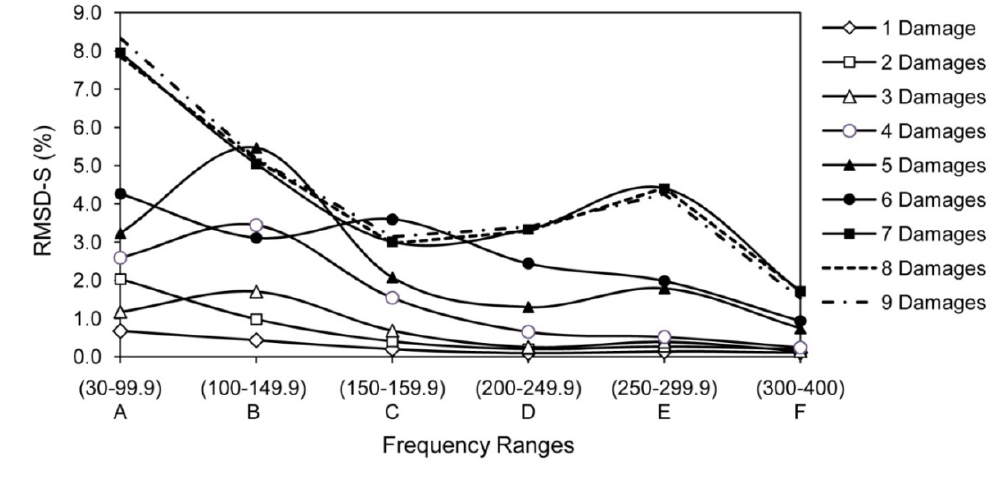
Figure 13. RMSD-S for cumulative effect of damages for PZT